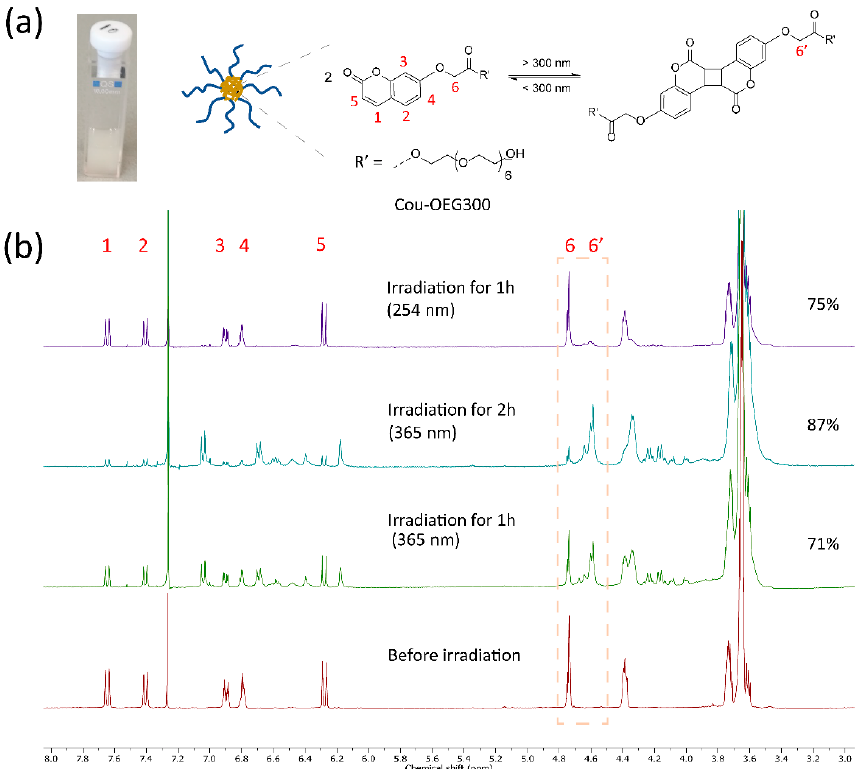
Figure 1. The model reaction of Cou-OEG300 under UV light. ( a ) Optical image of 10 mg/mL turbid Cou-OEG300 aqueous solution and UV-induced dimerization of coumarin units in micelles. ( b ) Reversibility study of UV-induced dimerization monitored by 1 H NMR.2.2. Synthesis of a Coumarin-Functionalized Photo-Crosslinker.